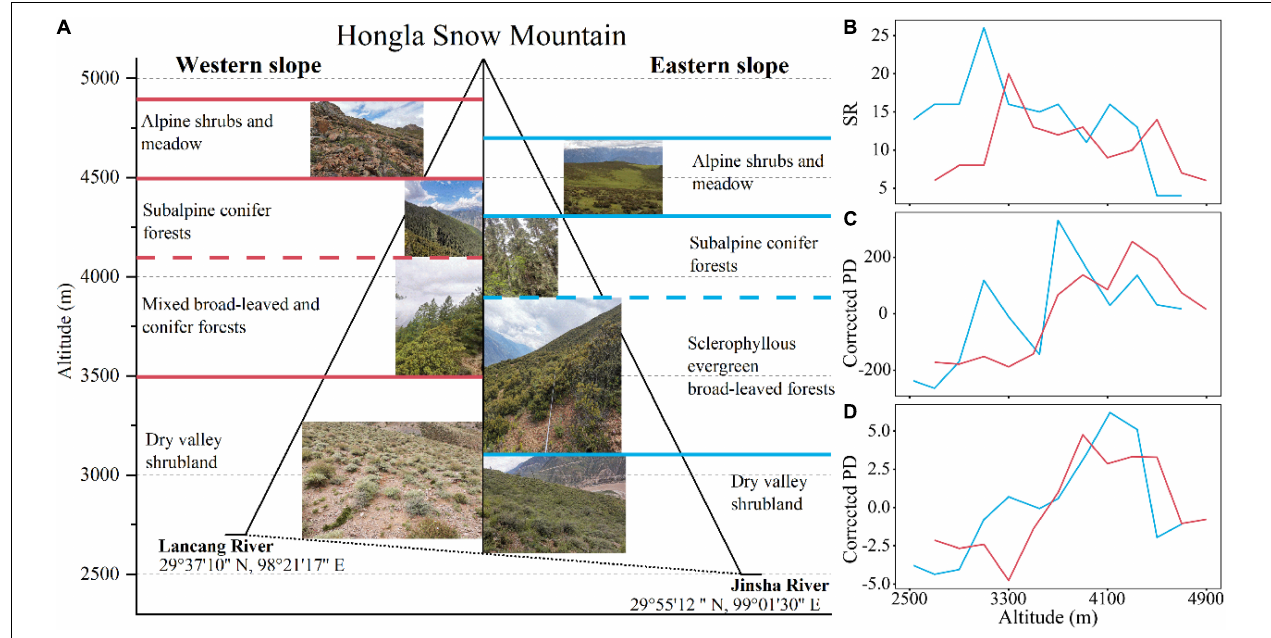
FIGURE 3 | The elevational patterns of vegetation types and taxonomic, phylogenetic, and functional diversity on two aspects of Hongla Snow Mountain. (A) Vegetation spectrum on both aspects. Red lines represent the boundaries between vegetation zones on the west slope, and blue lines represent those on the east slope. (B–D) Reflect the elevational patterns of SR, Corrected PD, and Corrected FD of woody species.